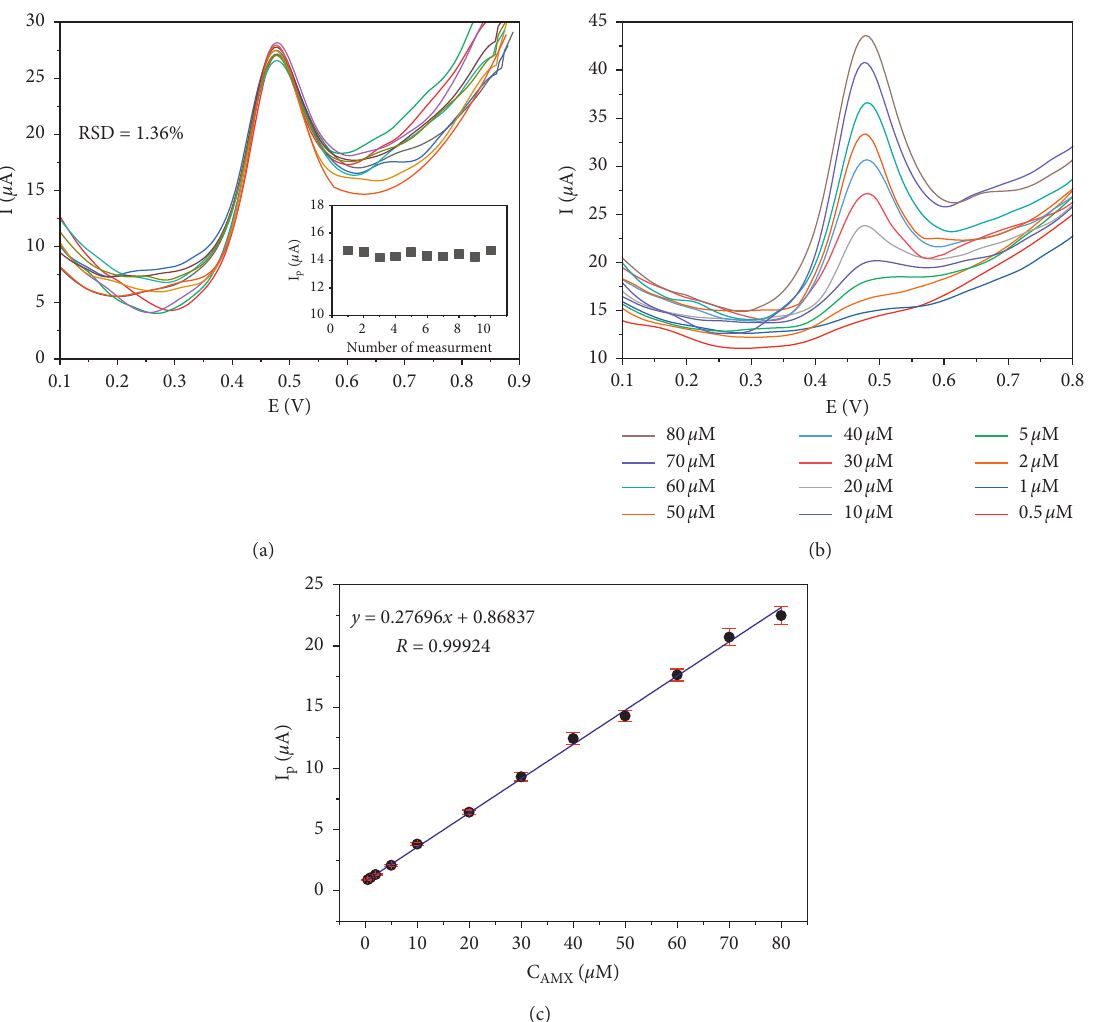
Figure 7: SWVs obtained on 10 different RGOnS electrodes at 50 µ M AMX (a), inset is AMX peak height in 10 measurements. The SWVs of AMX with concentration from 0.5 to 80 µ M(b) and calibration curve (c).